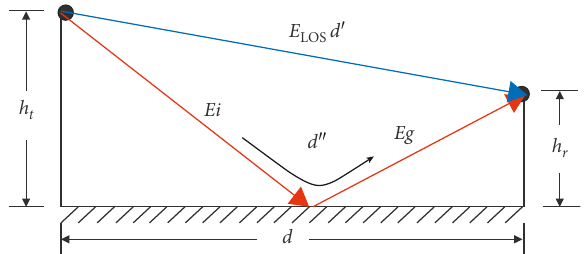
Figure 5: Multipath effect of indoor wireless signal